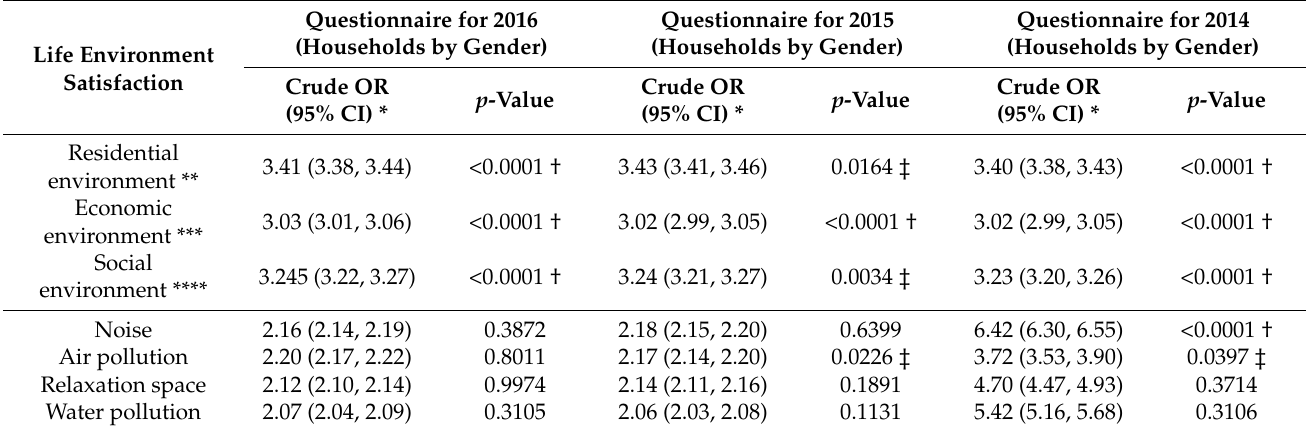
Table 2. Living environment and well-being in